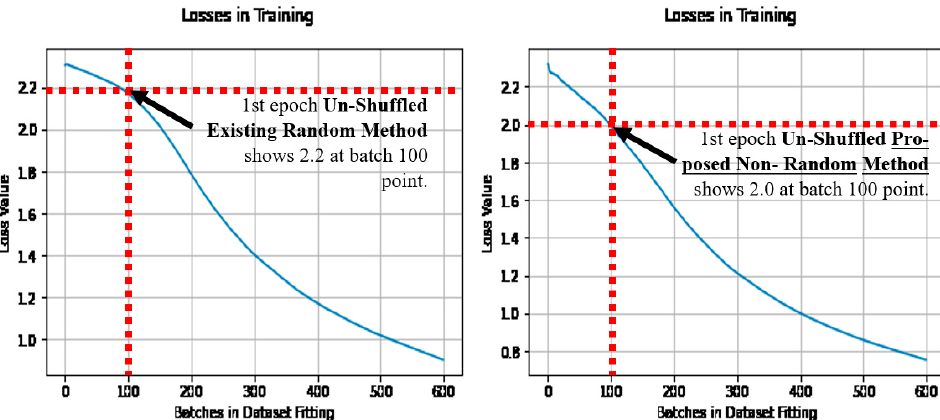
Figure 9. Losses over batches in fitting, when un-shuffled (with the existing method ( left ), and the proposed method ( right )).